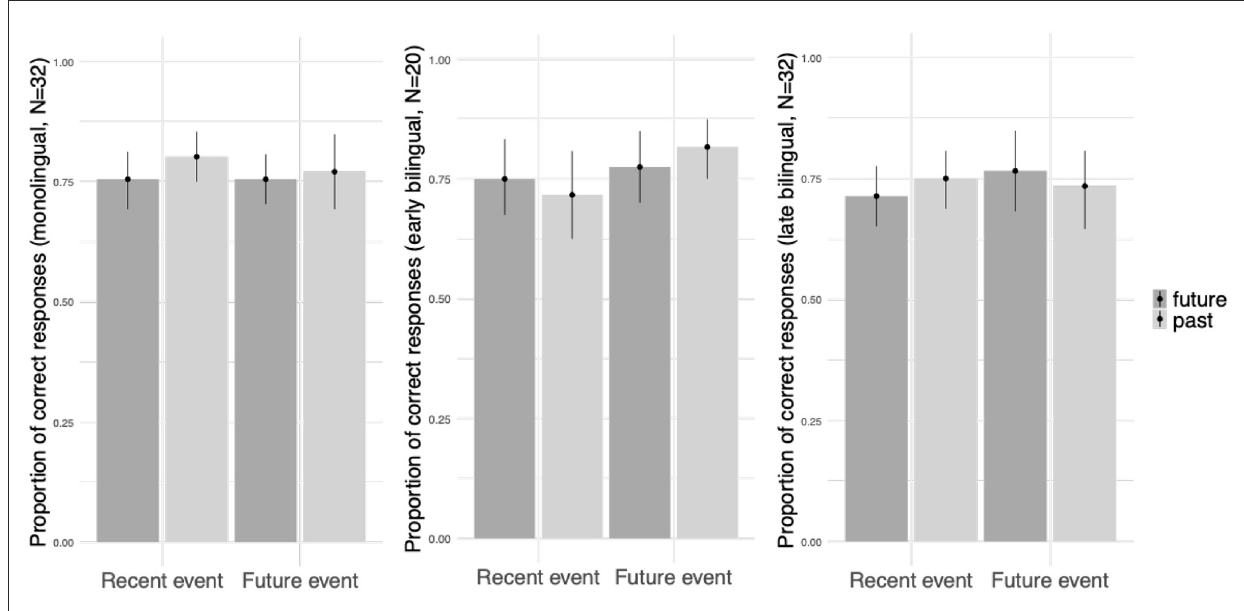
FIGURE4 Proportion mean of correct answers as a function of event and tense in Experiments 1, 2, and 3 (with error bars plotting the standard error of the mean).